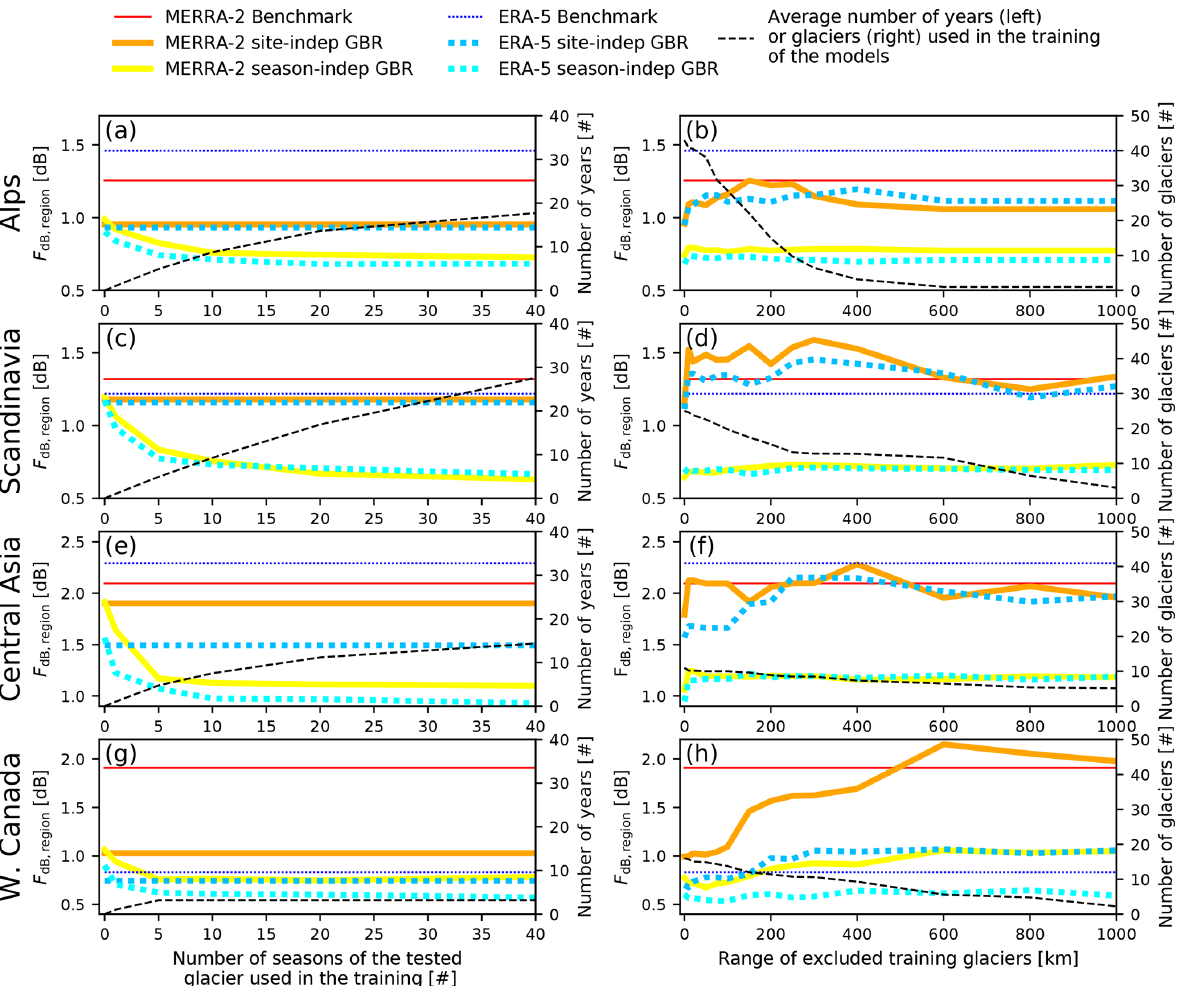
Figure 6. Evaluation of the mean regional factor between the B w data and the reanalysis-based models’ estimates ( F dB , region defined in Eq. 6) depending on different data used in the training of the GBR models. (a, c, e, g) Evaluation of the performance of the season-independent GBR models as a function of the number of seasons of the tested glacier used in the training (from no data to a maximum of 40 years of data of the tested glacier). (a) Model validation depending on the number of training seasons per glacier in the Alps, (c) Scandinavia, (e) Central Asia and (g) western Canada. (b, d, f, h) Evaluation of the robustness of the GBR models as a function of the number of other glaciers in the same region used in the training. All glaciers located within a range growing from 0 to 1000km from the tested glacier were excluded from the training. (b) Model evaluation depending on the range of excluded glaciers from the training in the Alps, (d) Scandinavia, (f) Central Asia and (h) western